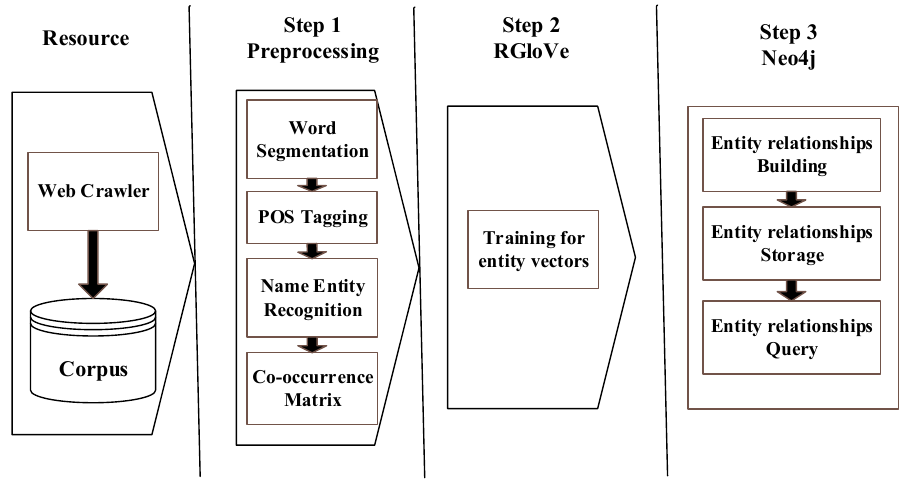
Figure 3. Our experimental framework for distributional entity relation representation.